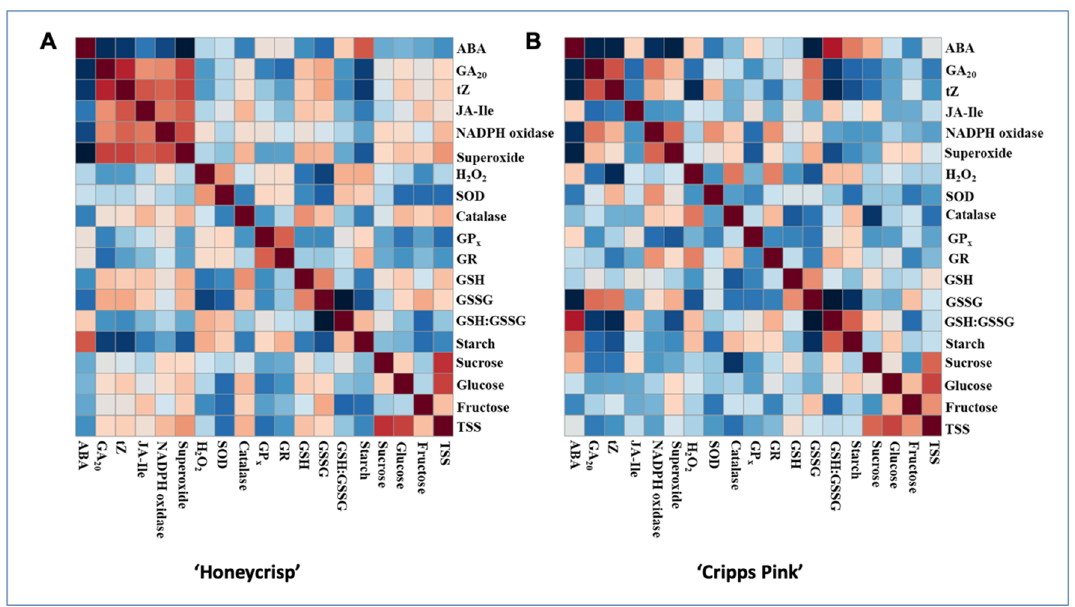
Figure 6. Heatmap analysis of Pearson’s correlation among variables measured in two apple cultivars, ‘Honeycrisp’ ( A ) and ‘Cripps Pink’ ( B ) from endodormancy induction to bud break stage. Red color indicates a positive correlation, whereas blue color indicates a negative correlation. The color intensity is proportional to the correlation coefficient.